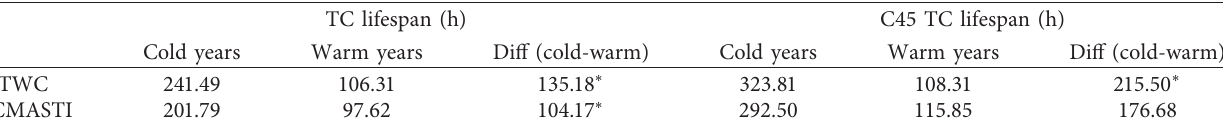
Figure 5: The average TCF in four quadrants from (a) JTWC dataset and (b) CMASTI dataset during JASON season. Table 3: Mean TC lifespan during JASON season in the subsurface cold and warm